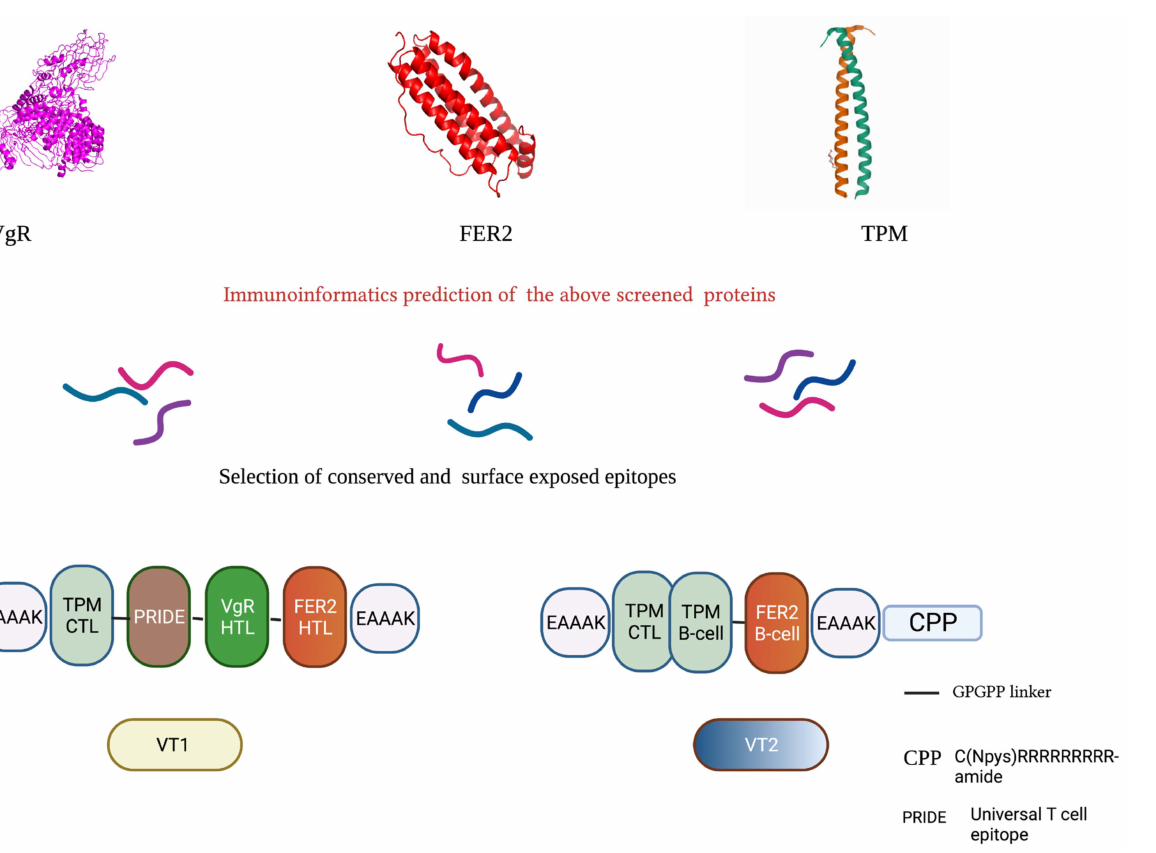
Figure 1. Schematic diagram of multi-epitopic peptide construct (created with biorender.com